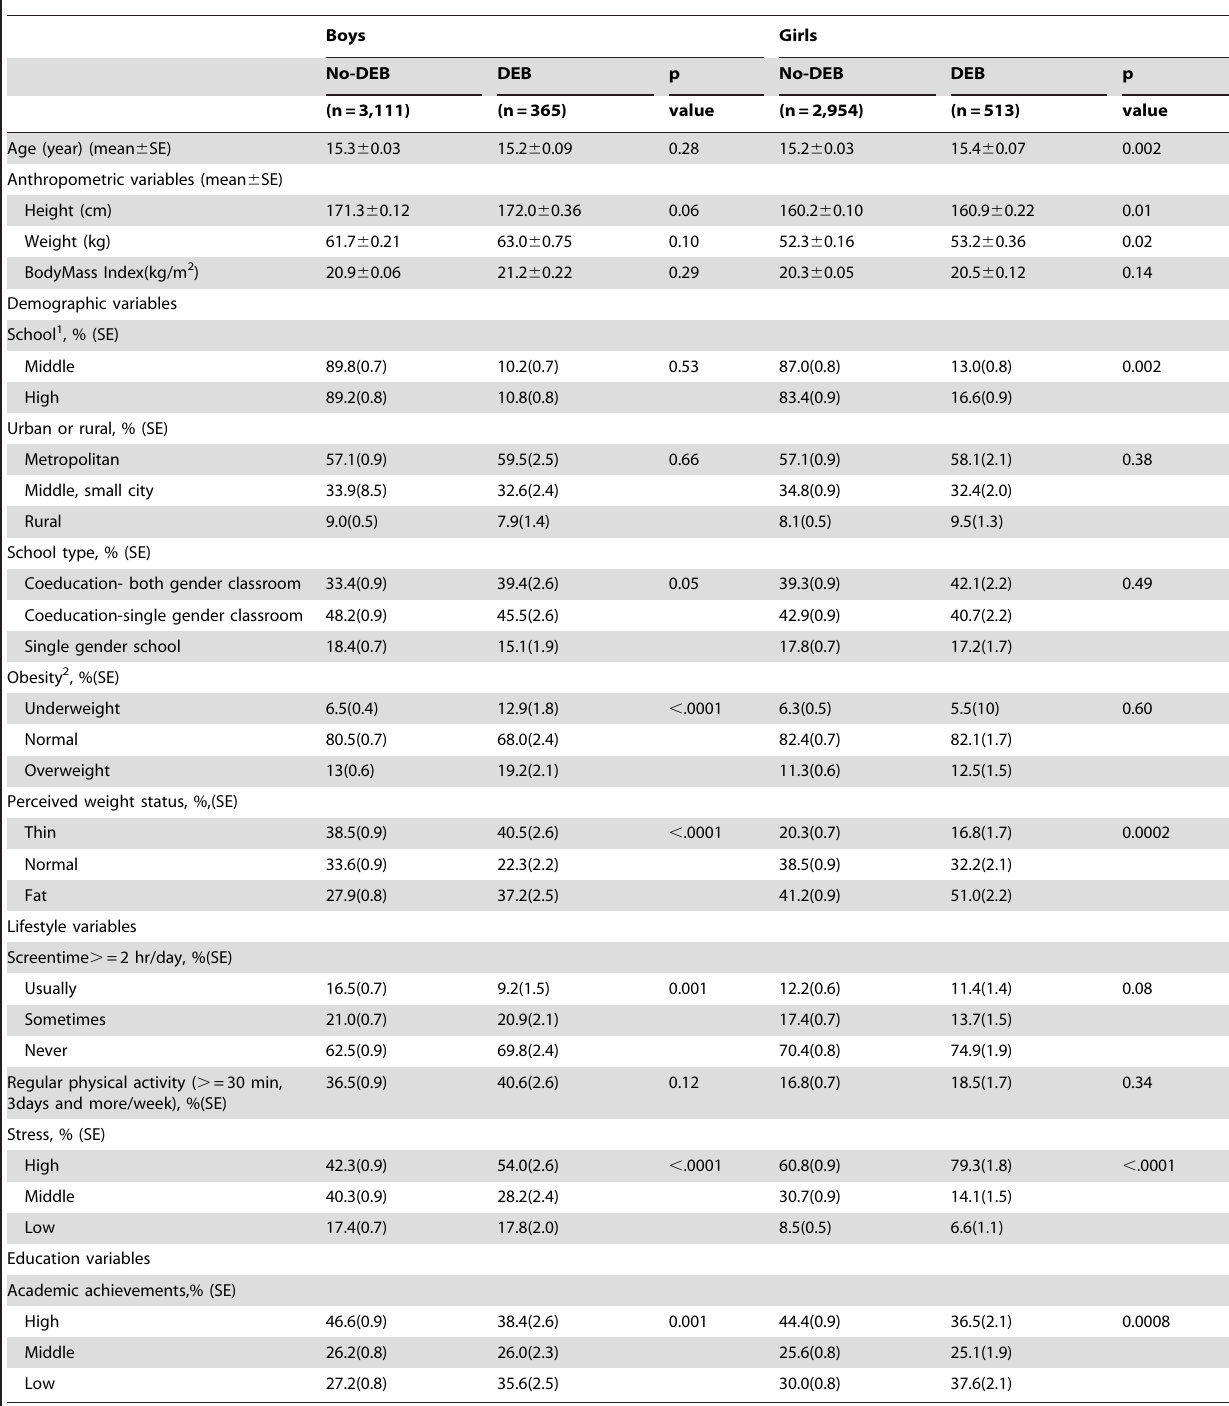
Table 1. Characteristics of boys and girls with or without Disturbed Eating Behavior